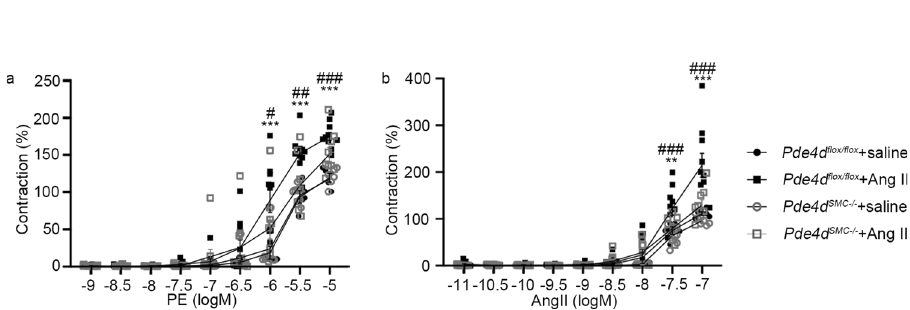
Fig. 3 Pde4d de fi ciency in SMCs affects vasocontraction. Concentration-response curves for a PE and b Ang II induced vasocontraction of mesenteric resistance artery from Pde4d fl ox/ fl ox and Pde4d SMC − / – mice with or without Ang II treatment ( n = 5 in Pde4d fl ox/ fl ox + saline group, n = 10 in Pde4d fl ox/ fl ox + Ang II group, n = 5 in Pde4d SMC − / − + saline group, and n = 8 in Pde4d SMC − / − + Ang II group). Data are expressed as mean±SEM. Two-way ANOVA with Bonferroni ’ s post hoc test was performed to compare the difference between the multiple groups. ** p <0.01 and *** p <0.001 for Pde4d fl ox/ fl ox + Ang II group vs. Pde4d fl ox/ fl ox + saline group. # p <0.05, ## p <0.01, and ### p <0.001 for Pde4d SMC − / − + Ang II group vs. Pde4d fl ox/ fl ox + Ang II knockout mice ( Tagln -Cre mice; Pde4d SMC − / − ) and Pde4d EC-